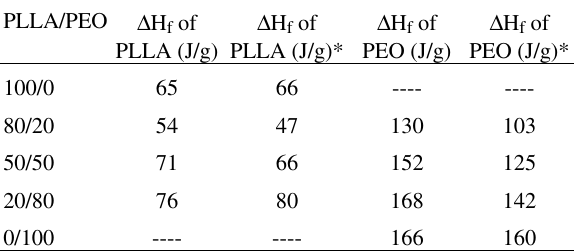
Table 4. Fusion enthalpy variation values of PLLA and PEO corrected as a function of the blend composition, for run 1 and run 2. These values correspond to t = 0.